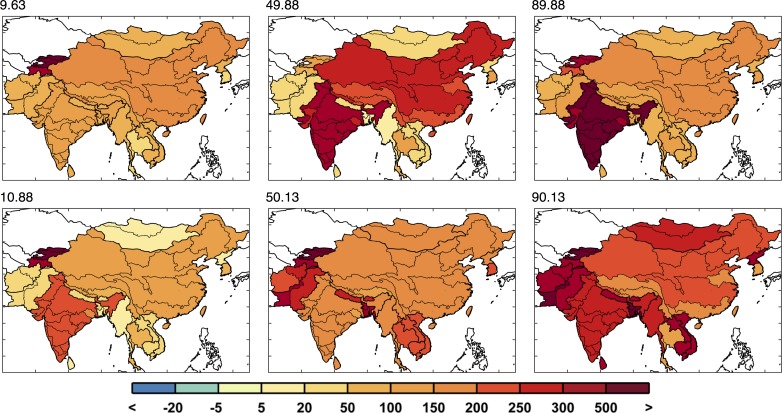
Industrial requirement change (in %) around the 10th percentile, median, and 90th percentile, two each, based on the mean industrial requirement change for the region (the metric used in Fig 22).Top label shows the percentile.